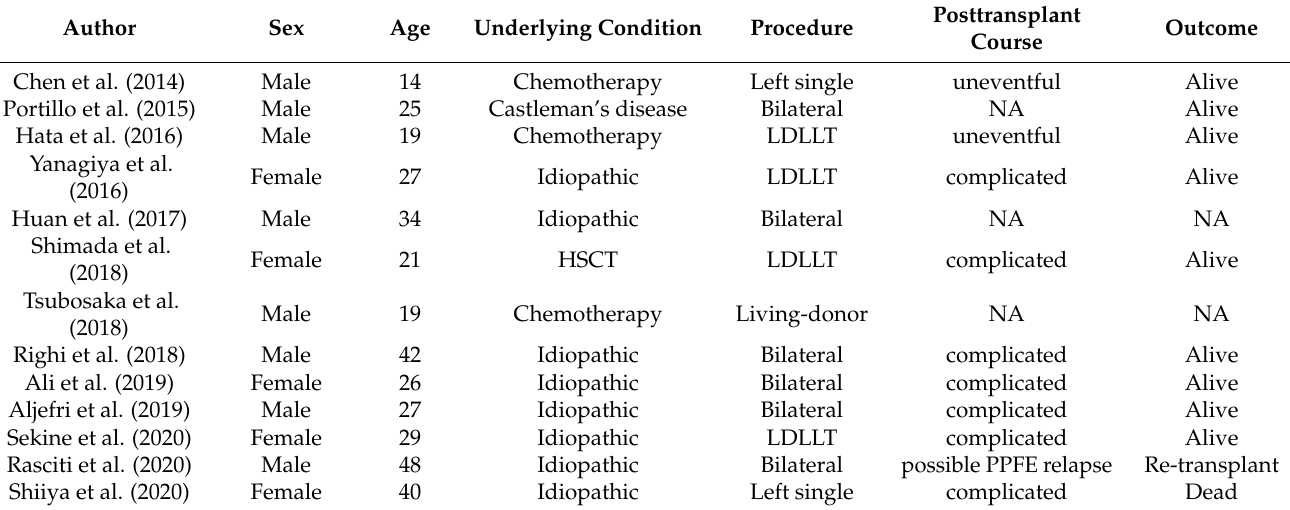
Table 1. Published case reports describing lung transplantation for